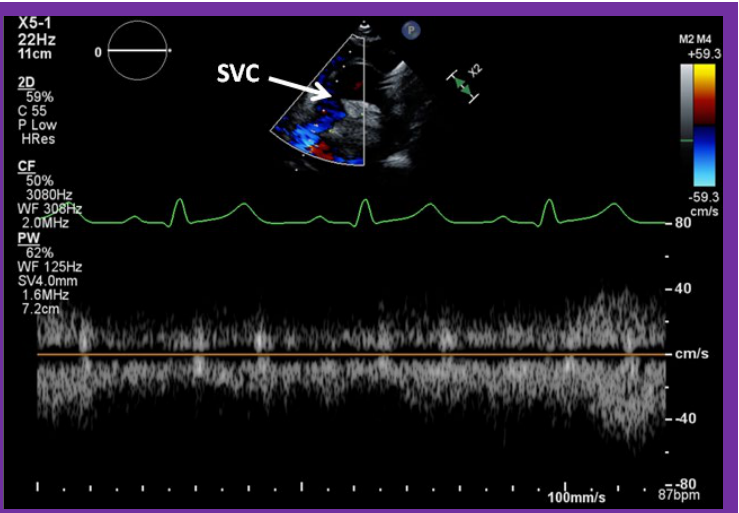
Figure 55. Selected video frames from suprasternal notch view, demonstrating low Doppler flow velocity across superior vena cava (SVC), bidirectional Glenn shunt and the conduit. Low Doppler flow velocity across the SVC, Glenn and the conduit indicates unobstructed Glenn component of the Fontan.